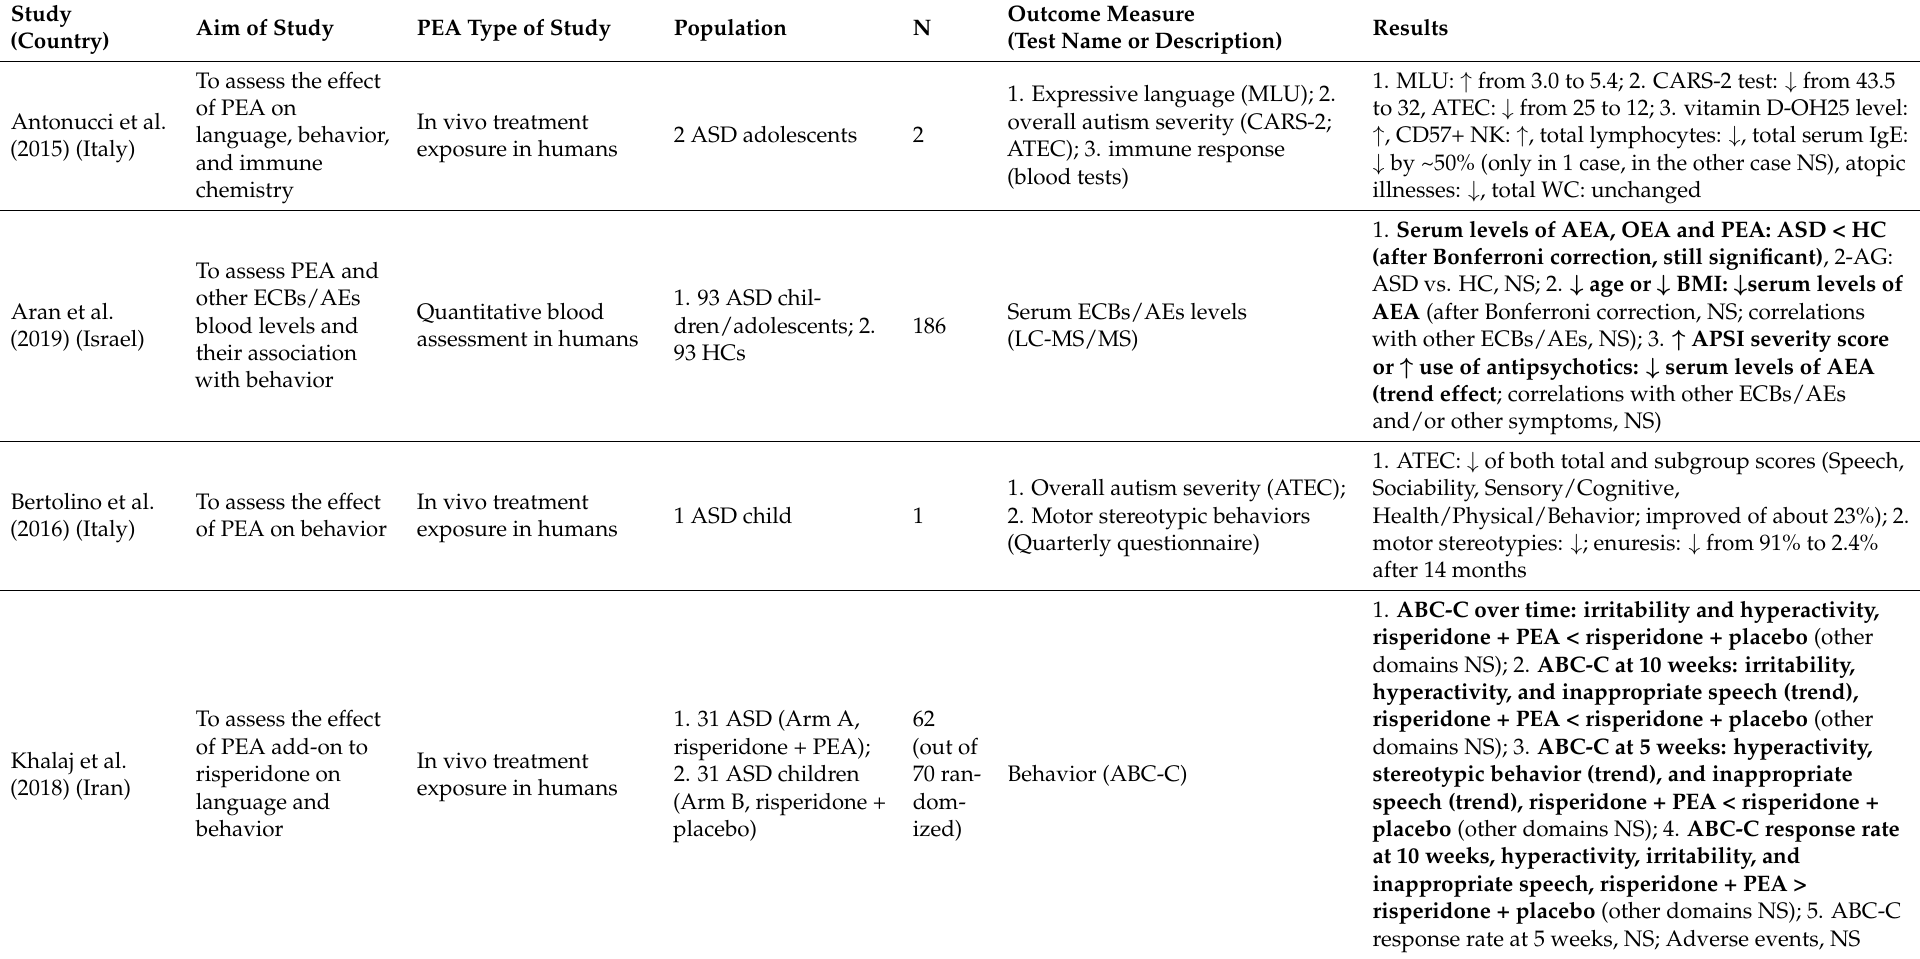
Table 1. Summary of studies investigating palmitoylethanolamide and its biobehavioral correlates in autism spectrum